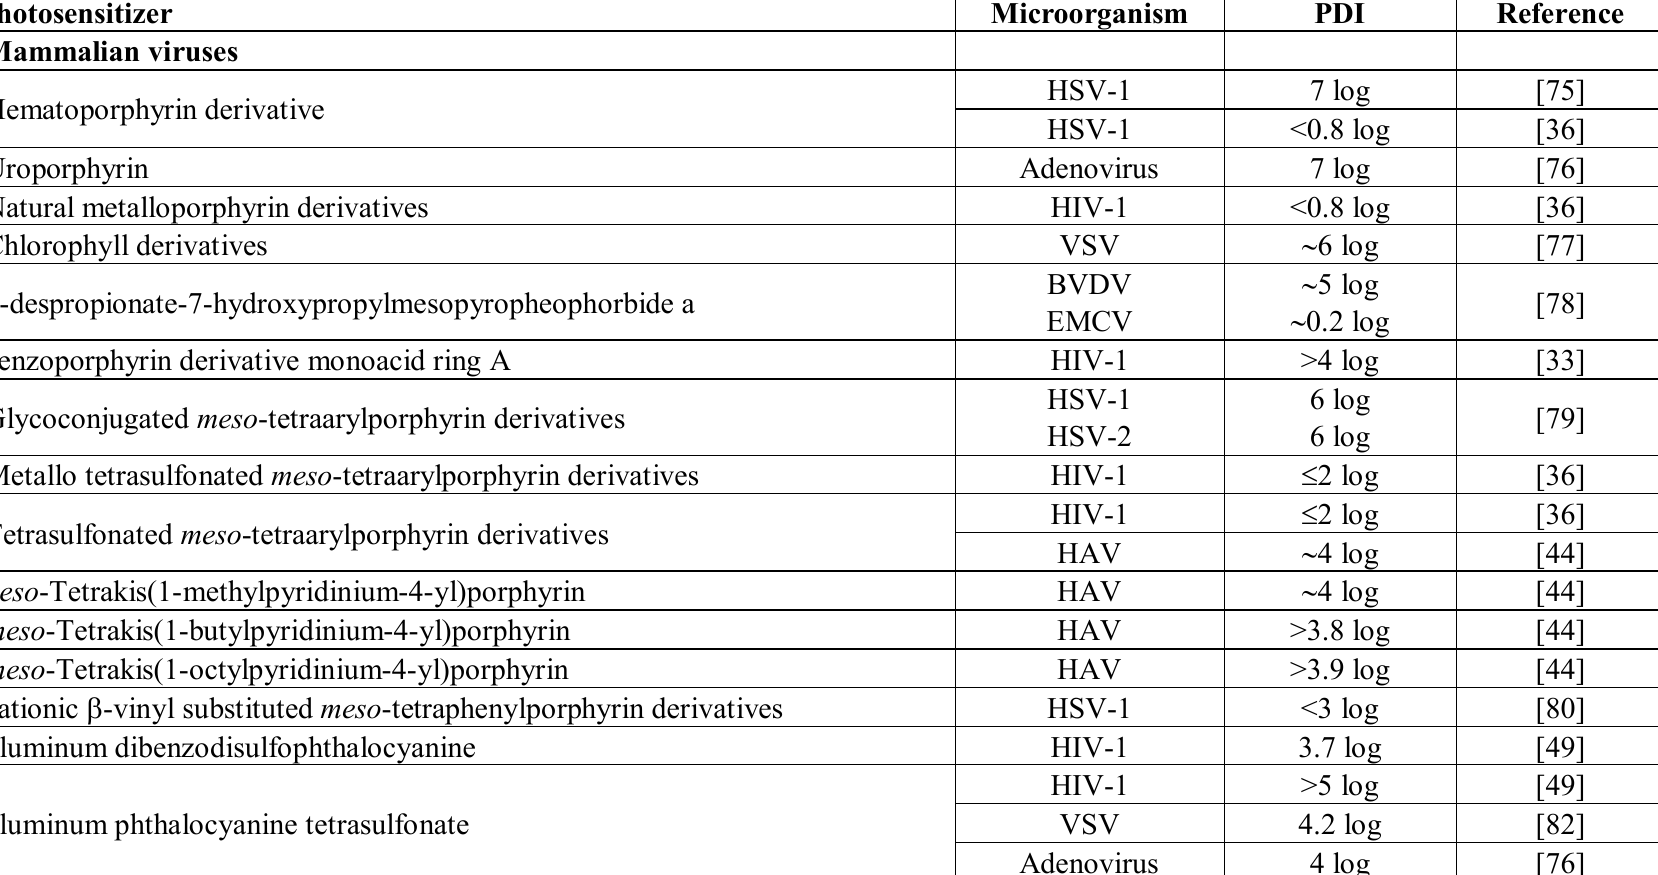
Table 1. Some PS used for mammalian viruses and bacteriophages